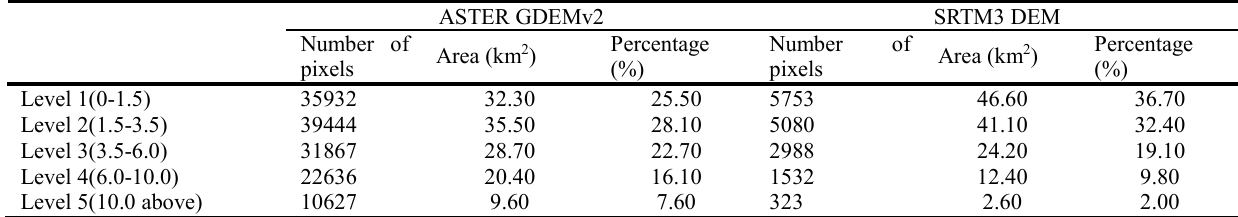
NOTE ： ASTER GDEMv2 431*326